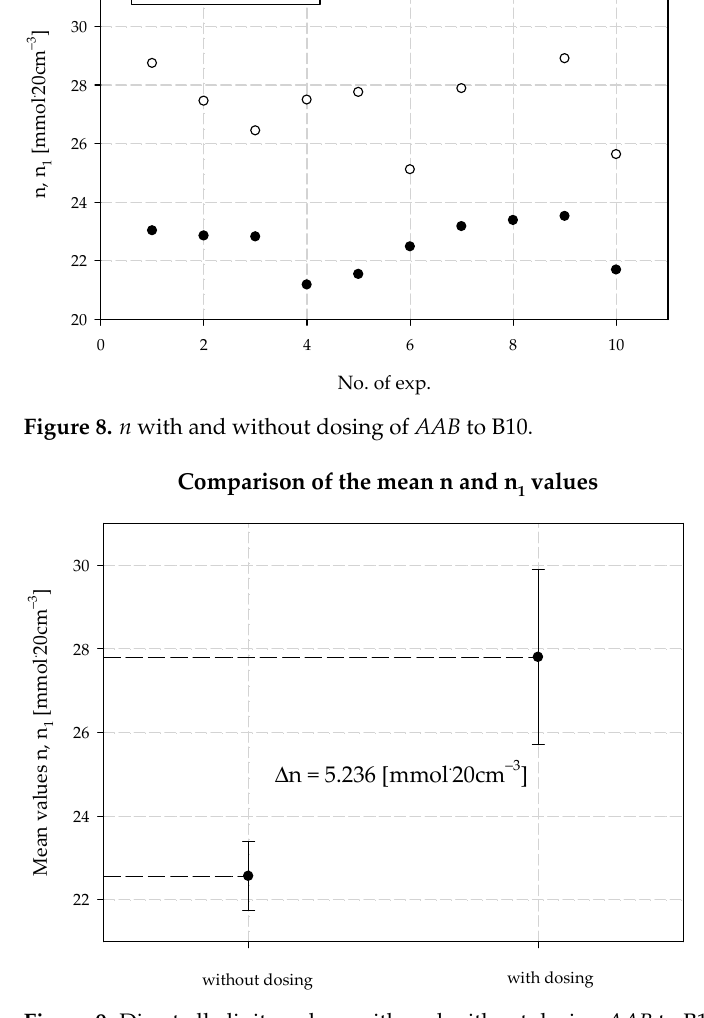
Figure 9. Direct alkalinity values with and without dosing AAB to B10.